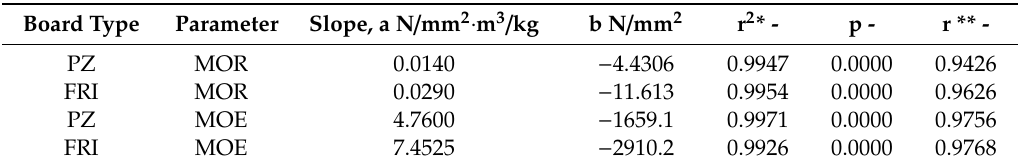
Table 4. Regression results for MOR/MOE – DENSITY relationship for boards with a linear model (MOR/MOE = b + a ).